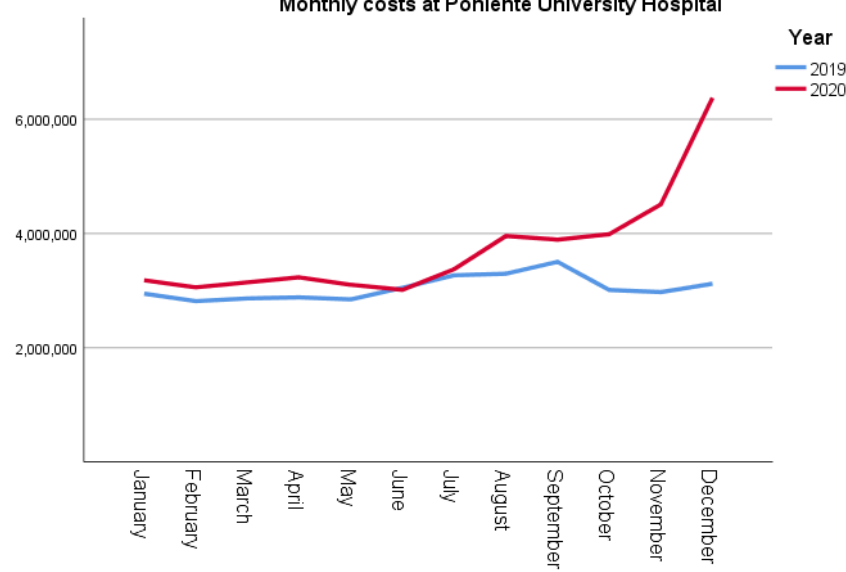
Figure 2. Comparative analysis of monthly costs at Poniente University Hospital.